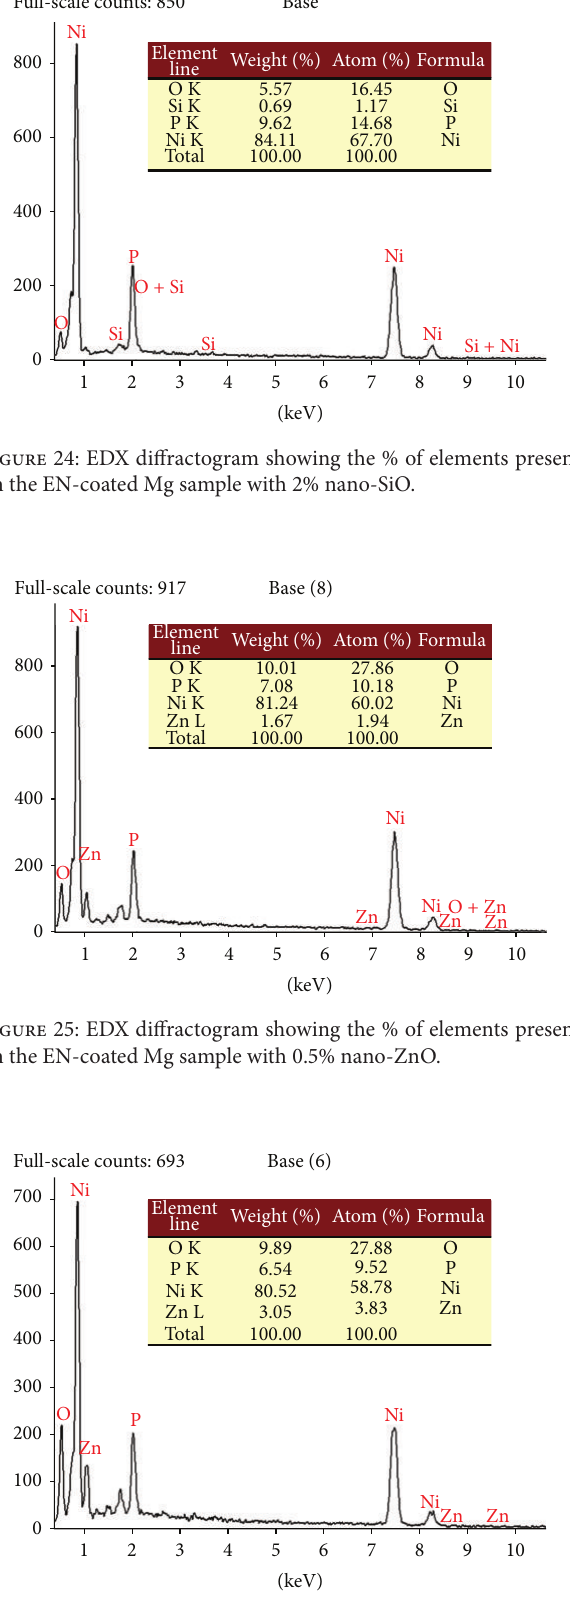
Figure 26: EDX diffractogram showing the % of elements present on the EN-coated Mg sample with 2%